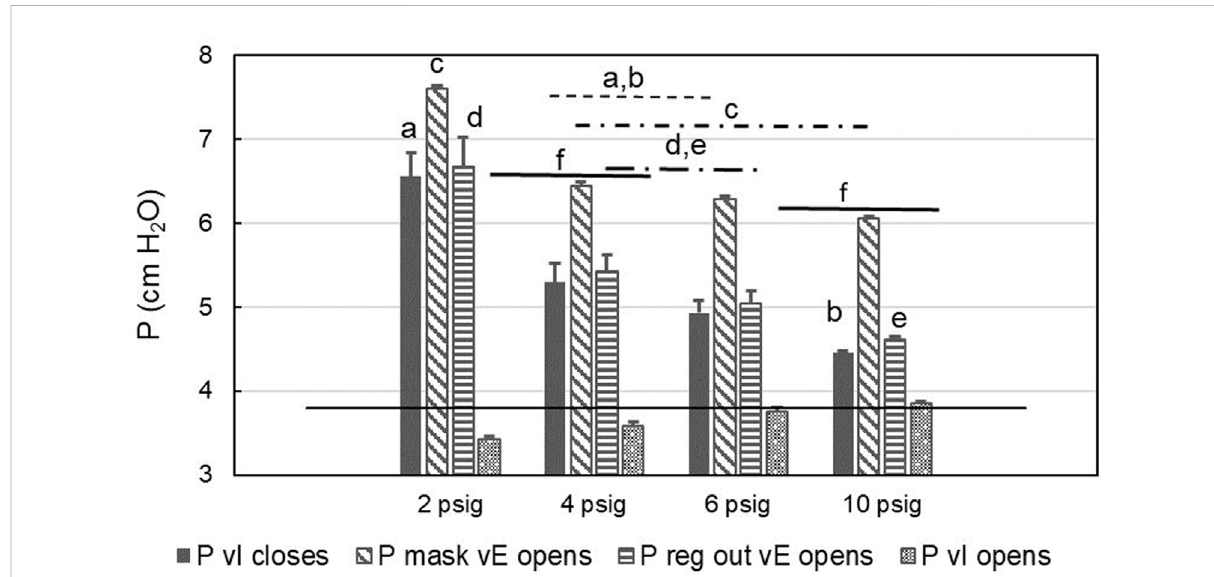
FIGURE 5 Mask and regulator output pressures when valves open or close. Means and SE across participants (200 s averages of breath-by-breath values) areshown.P=pressure,vI=inspiratoryvalve,vE=expiratory;blackline:nominalsafetypressure.Lettersandhorizontallinesabovethebarsindicate signi fi cant differences. The letters identify individual columns/comparisons and the horizontal lines indicate averaged values across conditions. For example, Column “ a ” (P vI closes at 2 psig) is signi fi cantly different from the mean of the same variable at 4 and 6 psig (indicated by the dashed line with “ a,b ” above it), which in turn is signi fi cantly different from Column “ b ” at 10 psig. Similarly, the mean of “ P vI opens ” across 2 and 4 psig is different from the mean across 6 and 10 psig.